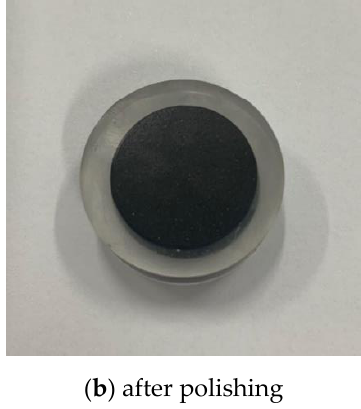
Figure 8. Asphalt mastic nanoindentation specimens.